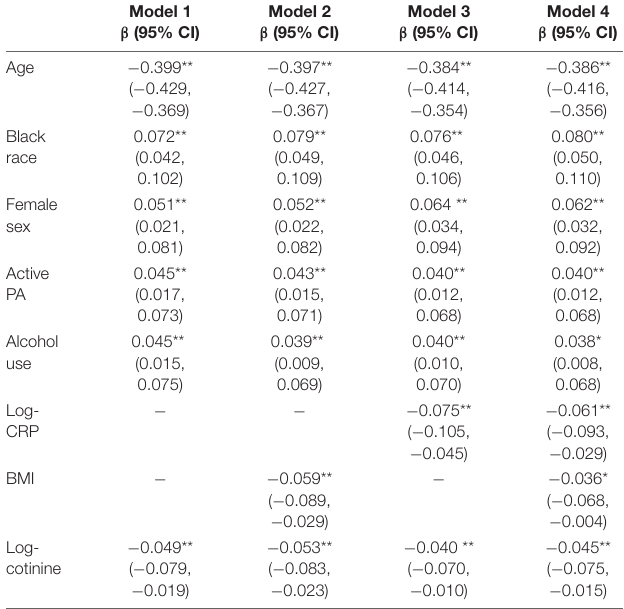
TABLE 2 | Standardized regression coefficients of serum cotinine, BMI and CRP on